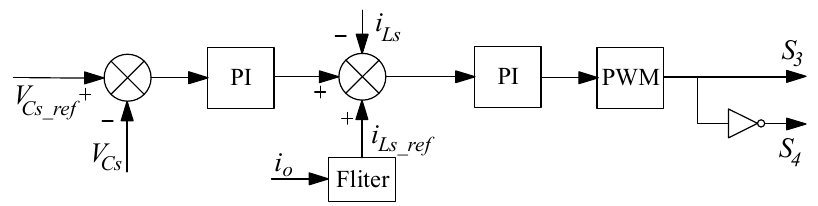
Figure 5. Bidirectional buck/boost converter based on average current control.